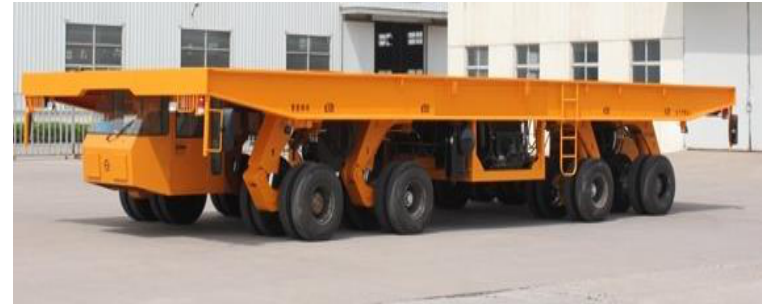
Figure 1. The hydraulic transport vehicle.